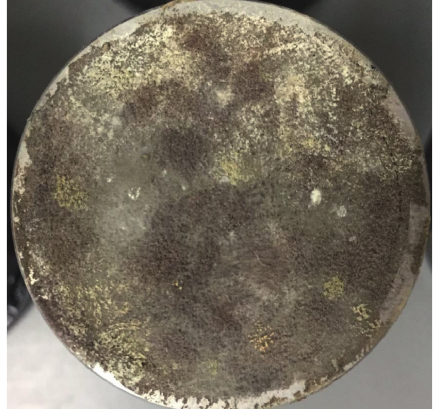
Figure 5: Photograph showing bacterial colonies on the surface of a 0.50mol/L specimen cured in the moisture cylinder for 28 days. Note that the clay specimen has not shrunk and the surface has not settled below the rim of the mold containing the specimen.